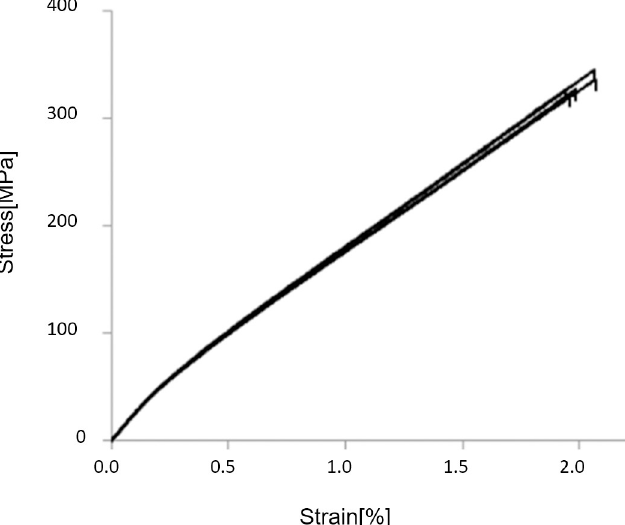
Fig 8. Measured stress-strain curves of the uniaxial flax fibre